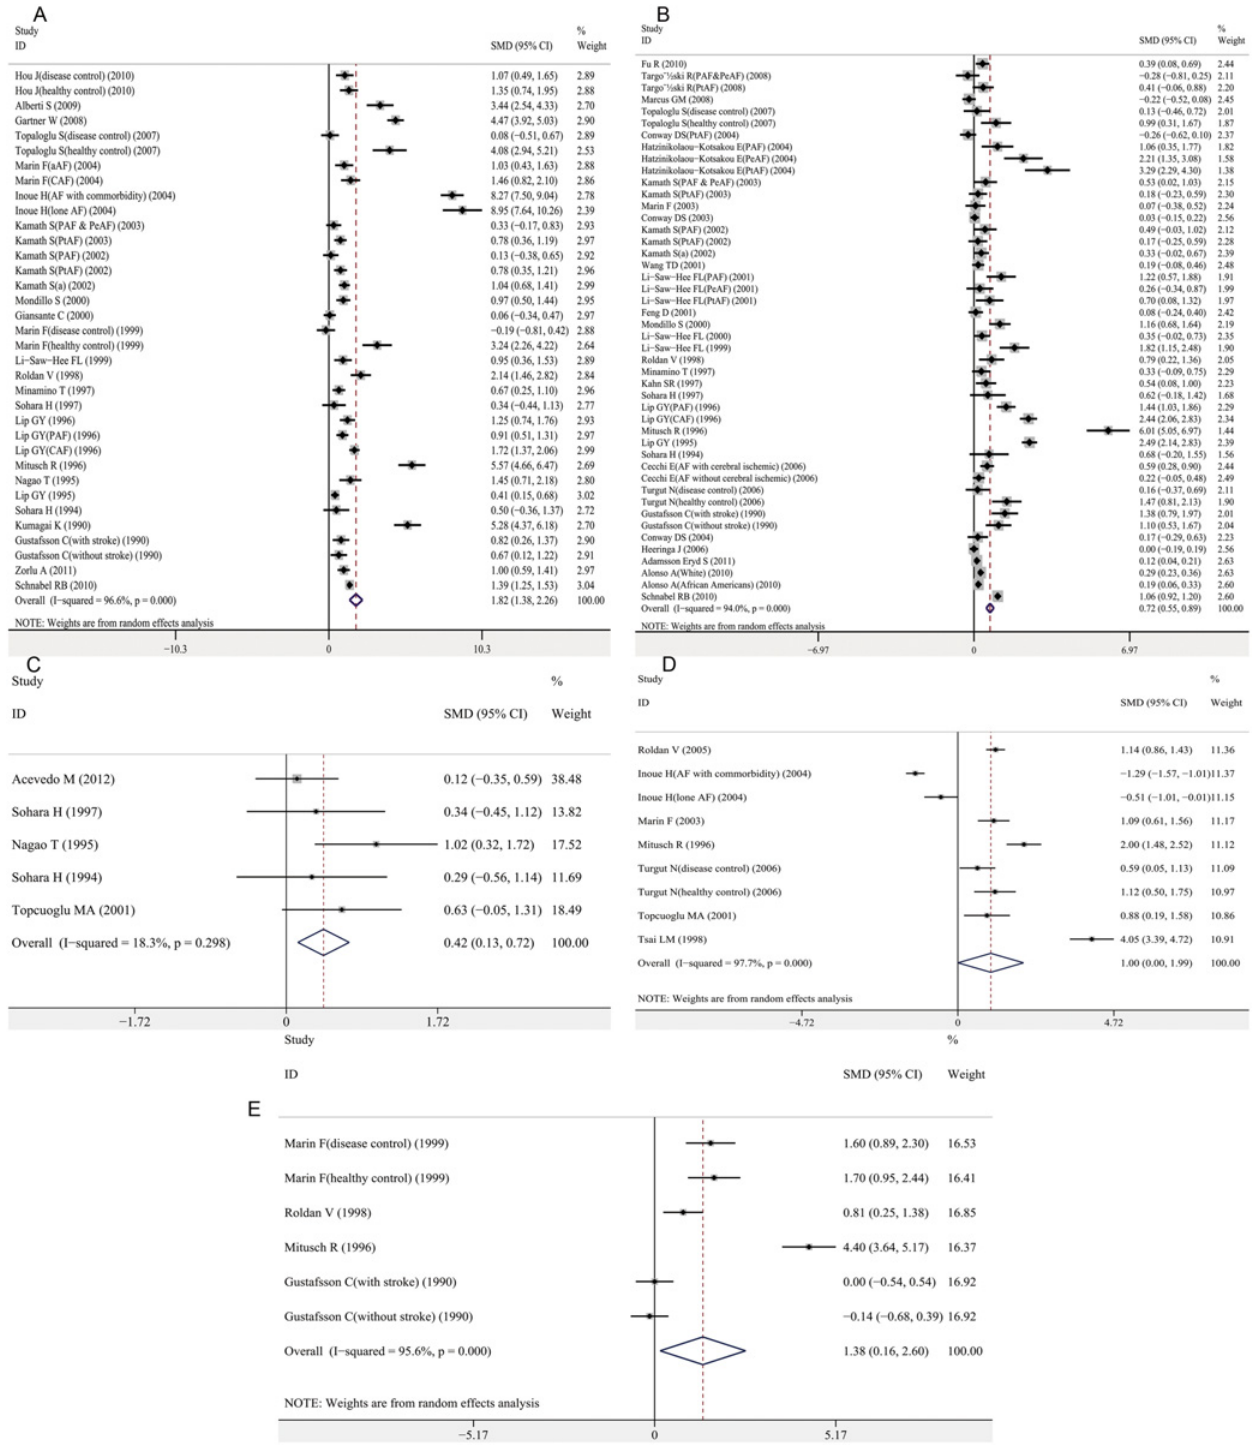
Fig 3. Association between coagulation activation markers and AF. A. D-dimer and AF; B. fibrinogen and AF; C. Thrombin-antithrombin and AF; D. Prothrombin fragment 1+2 and AF; E. Antithrombin- III and AF. Forest plots of SMD and overall SMD with 95% CI between AF cases and controls. Black diamonds indicate the SMD, with the size of the square inversely proportional to its variance, and horizontal lines represent the 95% CI. The pooled results are indicated by the black hollow diamond. AF, atrial fibrillation; TAT, thrombin-antithrombin; F1+2, prothrombin fragment 1+2; AT- III, antithrombin- III; PAF, paroxysmal AF; PeAF, persistent AF; PtAF, permanent AF; CAF, chronic AF; aAF, acute AF; SMD, standardized mean difference.